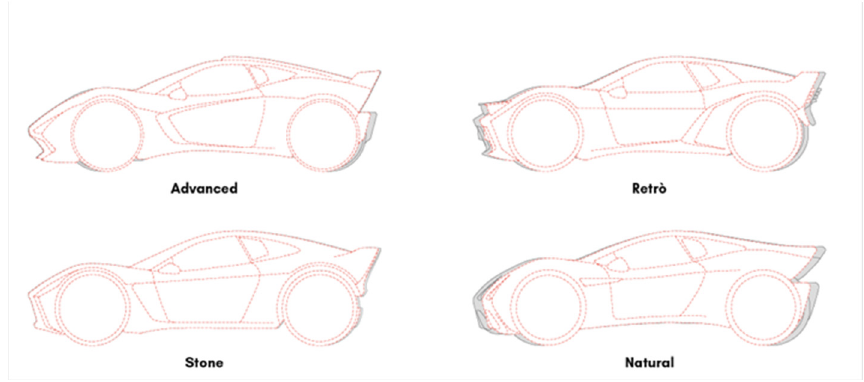
Figure 18. Direct overlay comparison between sketches and scaled 2D drawing.